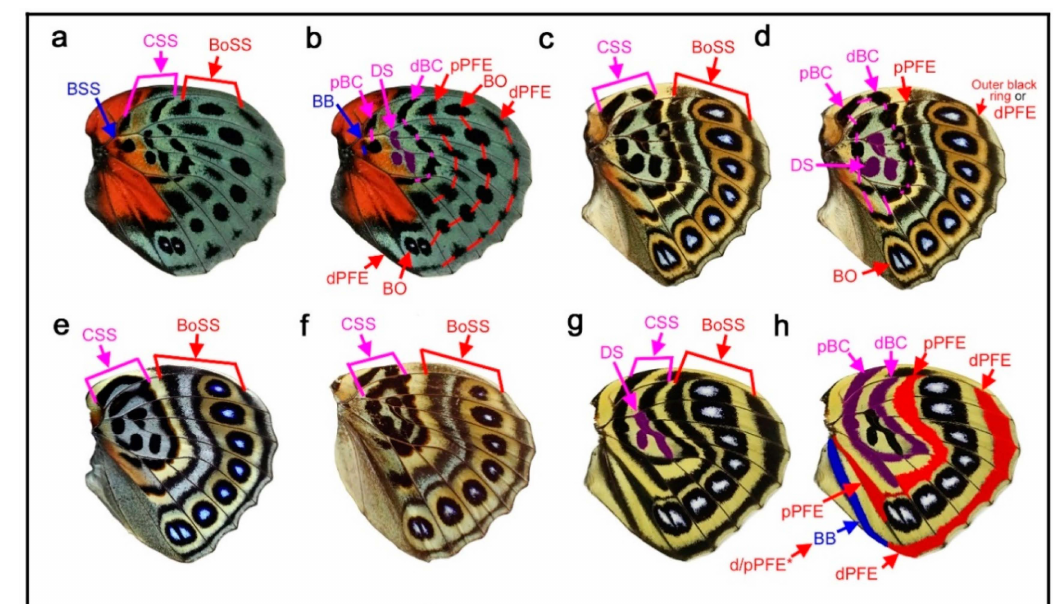
Figure 5. Diversity of the genus Agrias . See Figure 1b for abbreviations. ( a , b ) Agrias hewitsonius . These two wing images are identical except for the annotations. ( c , d ) Agrias claudina . These two wing images are identical except for the annotations. ( e ) Agrias claudina . This is a different individual from that in c and d. ( f ) Agrias sahlkei . ( g , h ) Agrias amydon . These two wing images are identical except for the annotations. An alternative identification of BB is indicated as